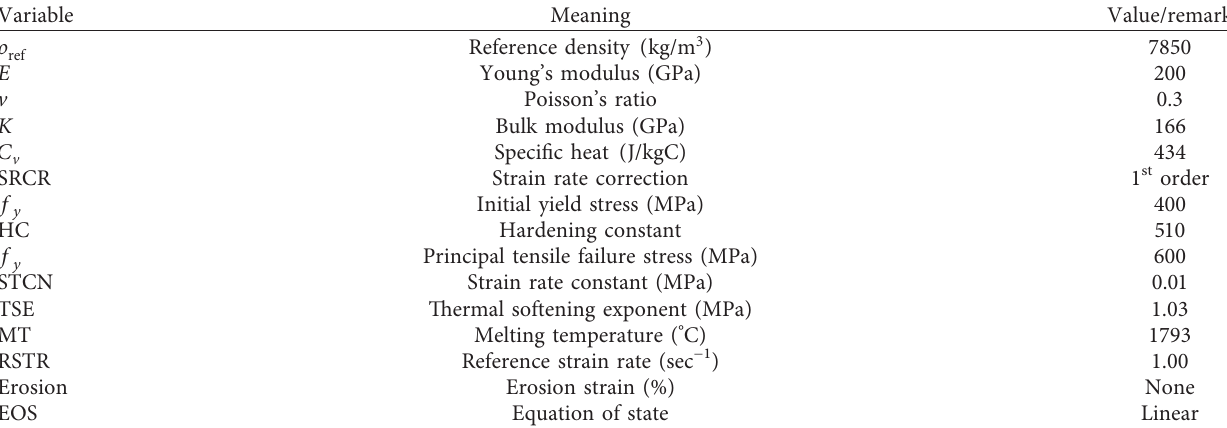
Table 5: Johnson–Cook strength model input parameters for S400 rebar.